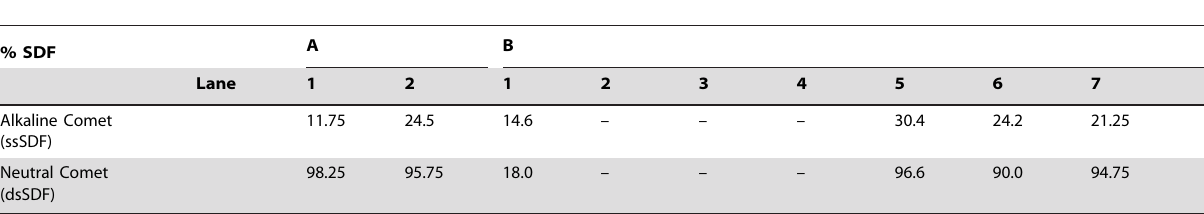
Table 2. Relation of samples shown in Figure 2 with their sperm DNA fragmentation.